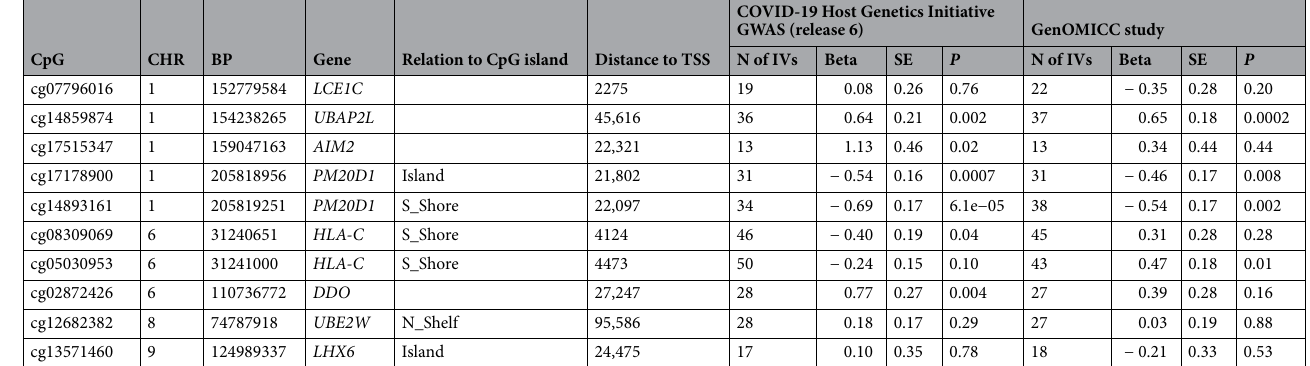
Table 4. Mendelian randomization analysis of putatively causal relations of COVID-19 severity-associated CpGs to COVID-19 severity. IVs are independent cis -mQTL variants with linkage disequilibrium R-squared < 0.1. Inverse variance weighted (IVW) method was used to conduct Mendelian randomization analysis, using data from two COVID-19 GWAS (COVID-19 Host Genetics Initiative 20 and GenOMICC study 19